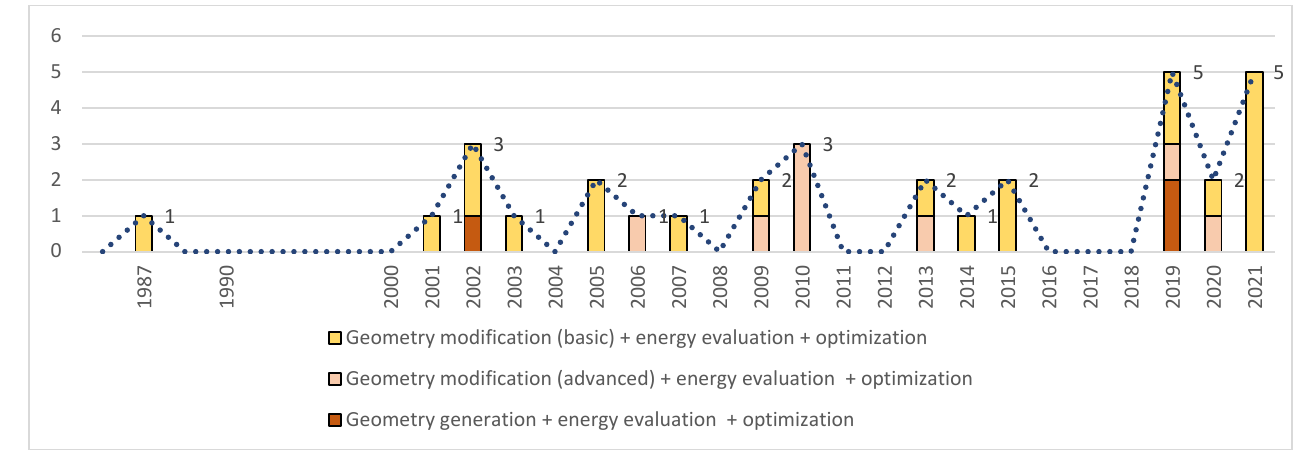
Figure 6. Studies with geometry modification and geometry generation with and without energy evaluation and optimization in chronological order.